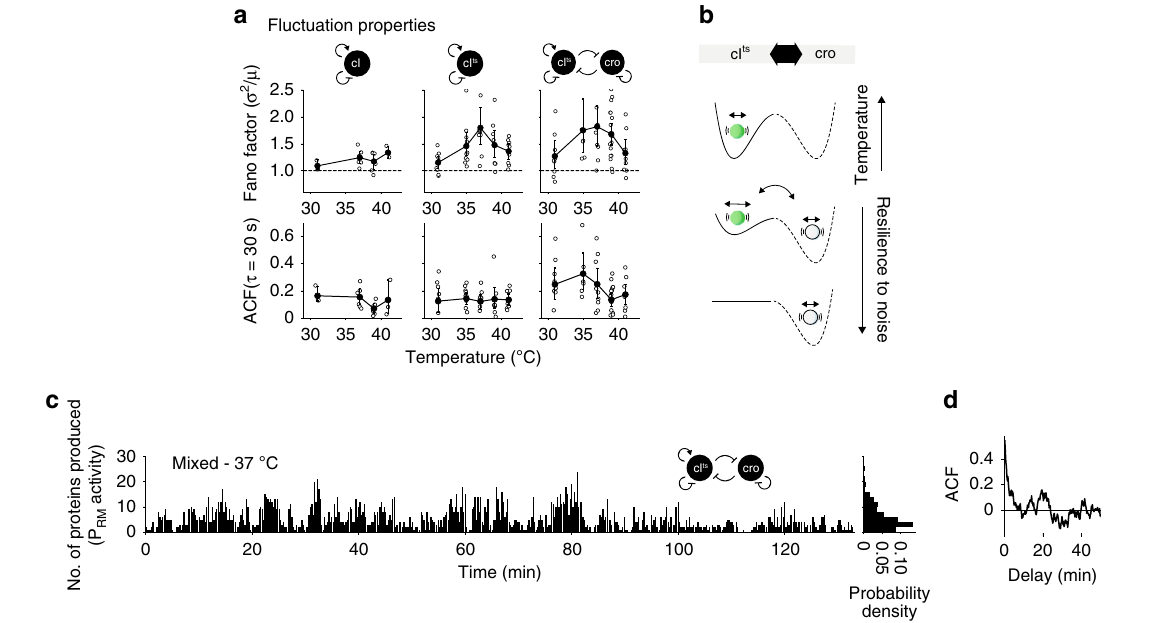
Fig. 4 Fluctuations and spontaneous transitions at the low-density limit. a Fano factor (variance over mean) with Poissonian process (dashed line) for the GRNs at various temperatures (upper row). Amplitude of temporal autocorrelation function (ACF) of fl uctuating production rates (as shown in Figs. 2c, 3a) in individual compartments at τ = 30 s. Error bars were bootstrapped and show mean and SD of compartments (see Supplementary Fig. 12 for the bistable and monostable GRN and Supplementary Fig. 14 for the wild-type monostable GRN). b Scheme of noise, active promoter transitions, and memory in the bistable GRN. Short-term fl uctuations in gene expression (circle within a well) originate from local noise. Long-term fl uctuations can originate from spontaneous promoter transitions with the deactivation of CI ts . c Number of proteins produced in 15 s for long-term experiment of the bistable GRN at 37 °C. d The ACF of the trace in panel c. Source data are provided as a Source data fi